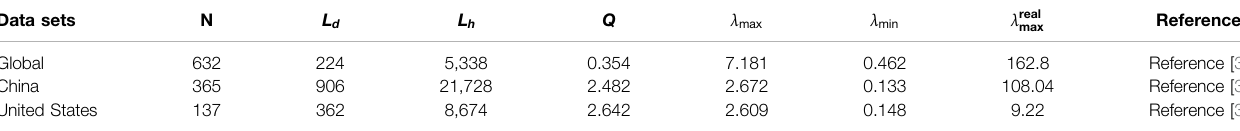
TABLE 1 | The basic properties of the three data and parameters of the RMT analyses. Data